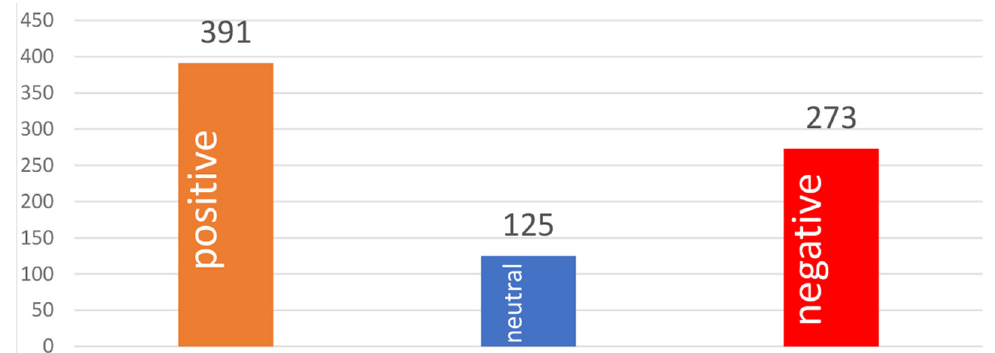
Figure 4. Sentiment polarity distribution of the tweets.